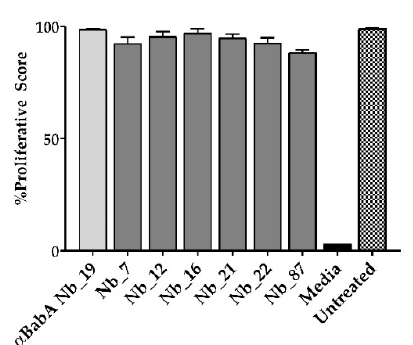
Figure 3. Six anti-CD33 Nbs bind native CD33 protein expressed on THP-1 cells, without affecting the cells’ in vitro proliferative capacity. ( A ) Individual histogram plots of flow cytometry analysis from the selected Nbs (clear peak) versus a non-targeting Nb (tinted peak). An anti-CD33 monoclonal antibody was used as positive control (clear peak), with an isotype-matched antibody as negative control (tinted peak). ( B ) Graphical representation of the ∆ MFI values for the generated Nbs. The ∆ MFI is defined as the MFI signal from THP-1 cells treated with Nb and HA-labeled monoclonal antibody subtracted with the MFI signal from cells and labeled monoclonal, but without Nb. An Nb was selected as a binder if its ∆ MFI signal was at least three times higher than the one obtained with non-targeting binder ( α BabA Nb_19), which defined the threshold (dashed line). ( C ) The impact of ant-CD33 Nbs on the proliferation of THP-1 cells was determined by the alamarBlue assay, in which the proliferative status measured by absorbance is translated into a bar plot. THP-1 cells were incubated for 48 h, with 5 µ g of the selected anti-CD33 Nbs (gray bars) or a non-targeting Nb ( α BabA Nb_19; light grey bar), or they were left untreated (patterned bar). Medium alone was also included as extra control condition (black bar).